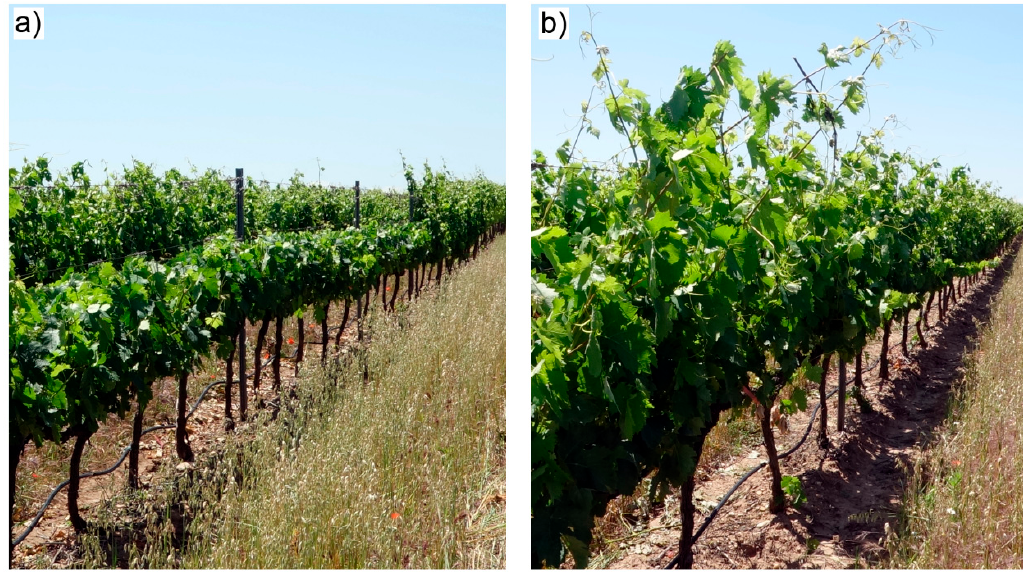
Figure 4. Pictures after the shoot trimming detection experiment in Ausejo: ( a ) Shoot trimmed vines, ( b ) control